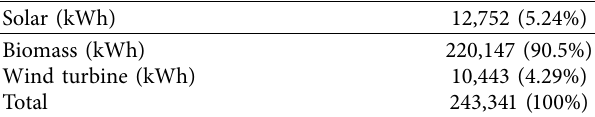
Table 8: The amount of energy fraction extracted in different ways.